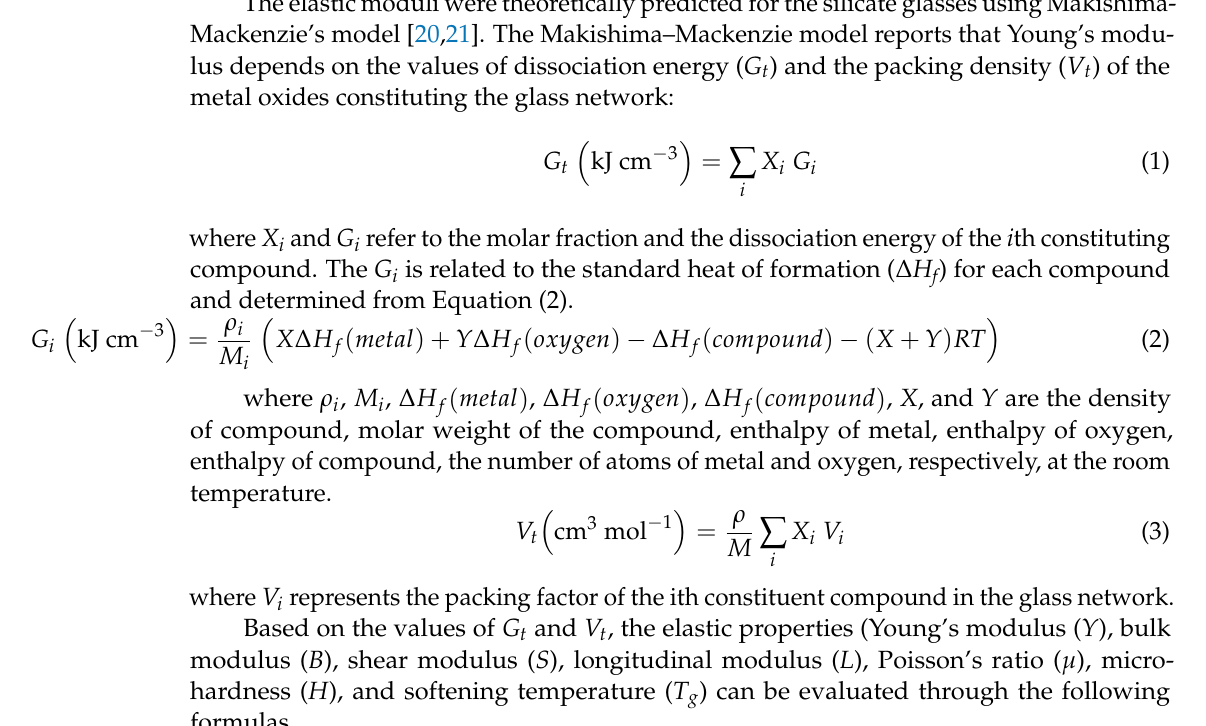
Table 1. The chemical composition, density molecular weight, and molar volume of the investigated glasses. Chemical Composition (wt%) Density Glass Code 2 O